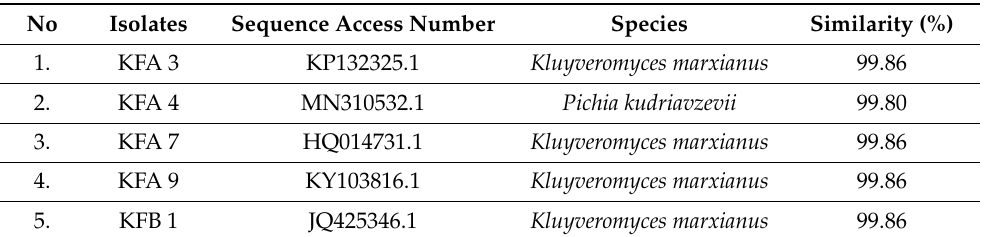
Table 2. Nucleotide sequence similarity of the ITS rDNA of five yeast isolates with sequences of Kluyveromyces and Pichia species.